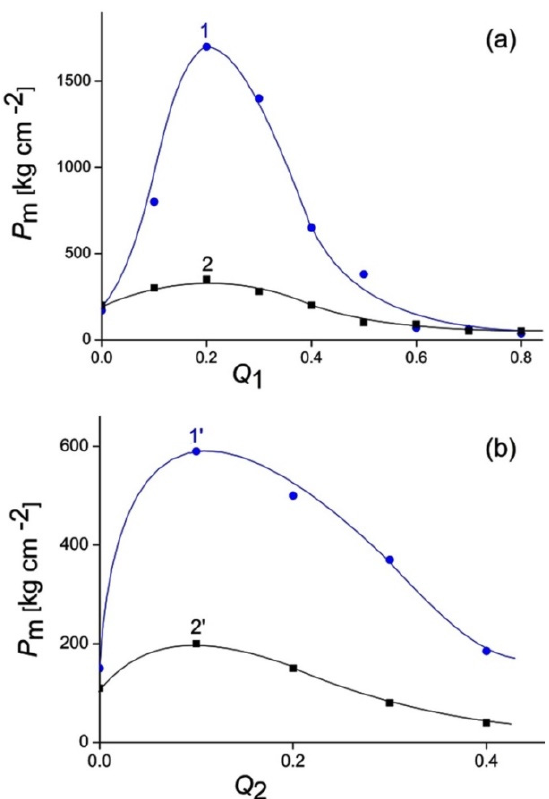
Figure 6. Mechanical strength of polymer–soil/sand crusts vs. composition of deposited IPEC for- mulations. ( a ) Cationic IPEC and ( b ) anionic IPEC; sand (1 and 1 ′ ) and soil (2 and 2 ′ ). formulations. ( a ) Cationic IPEC and ( b ) anionic IPEC; sand (1 and 1 (cid:48) ) and soil (2 and 2 (cid:48)